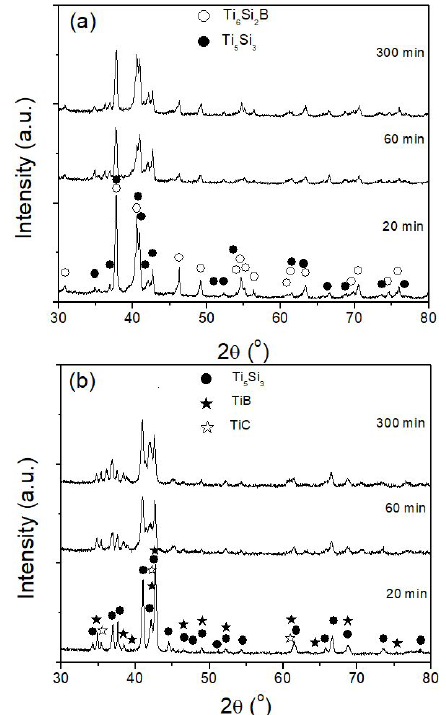
Figure 4. XRD patterns of the spark plasma sintered (a) Ti-2Co- 22Si-11B and (b) Ti-6Co-22Si-11B alloys produced with powders previously milled for 20 min, 60 min and 300 min.